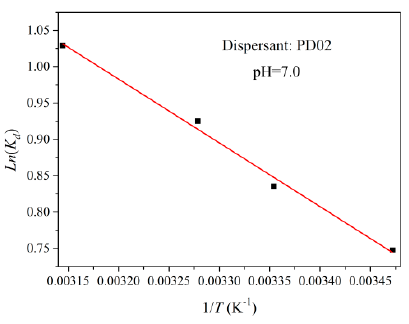
Figure 10. Plot of Ln ( K d ) versus 1/ T for dispersant PD02 adsorbed on the surface of the S-ZnF particles. Table 5. Thermodynamic characteristics for dispersant PD02 adsorbed on the surface of the S-ZnF particles.